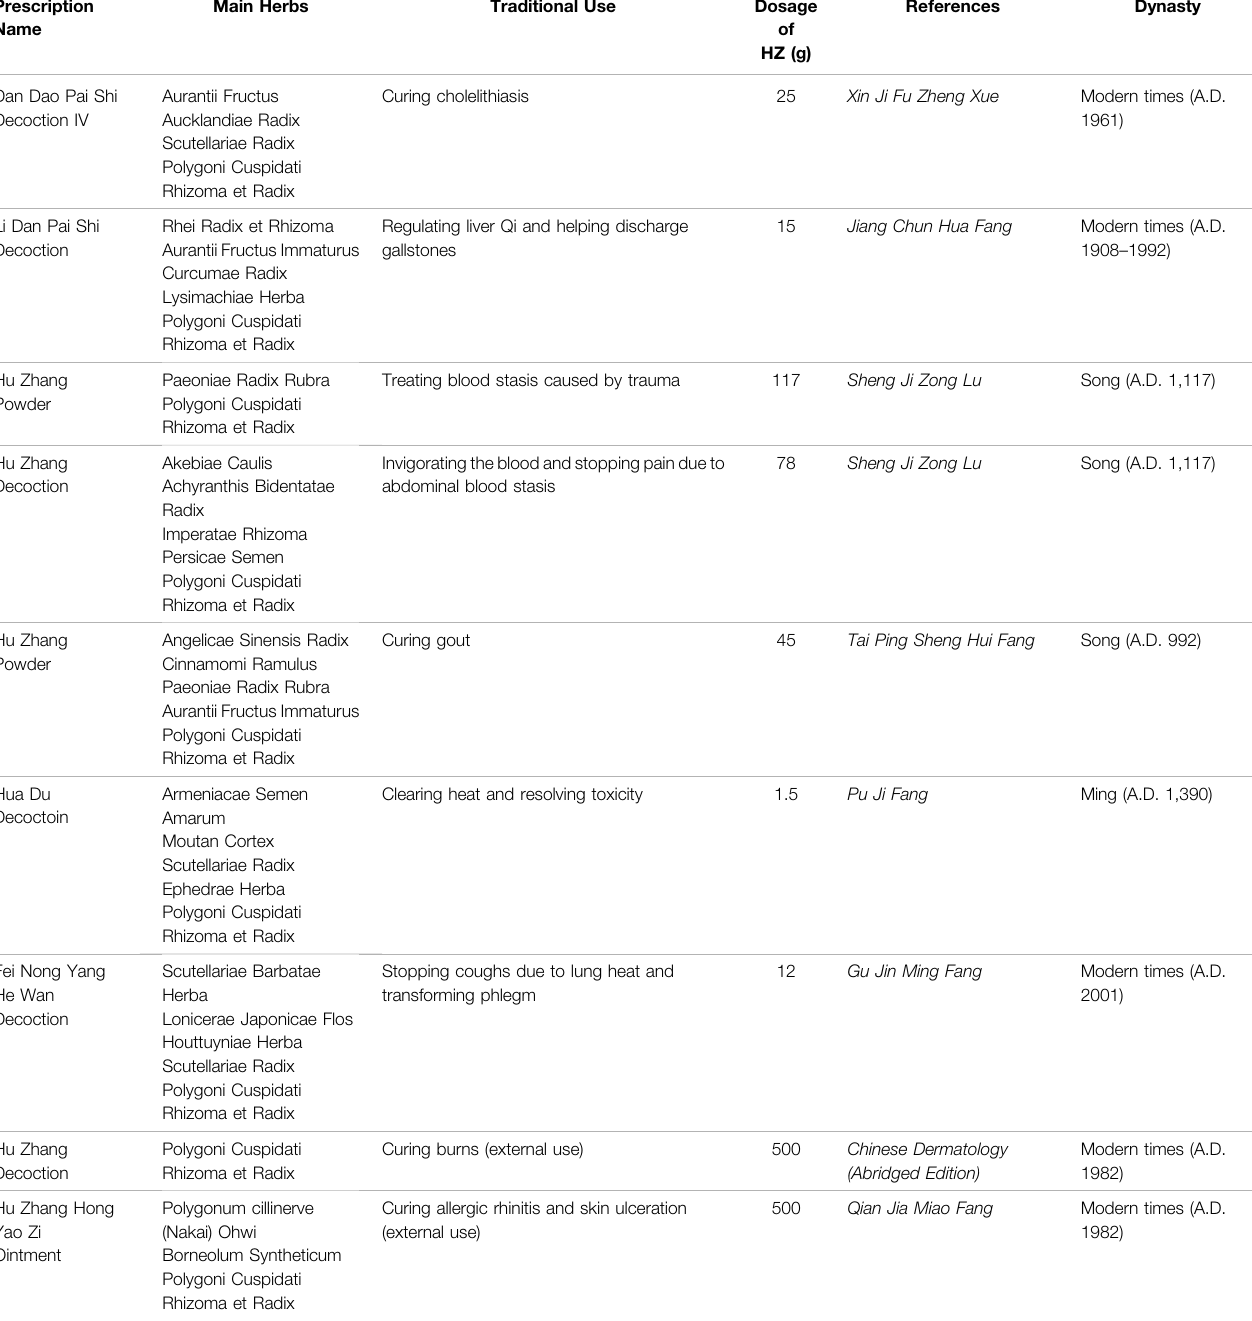
TABLE 2 | Application of HZ in classical prescriptions of